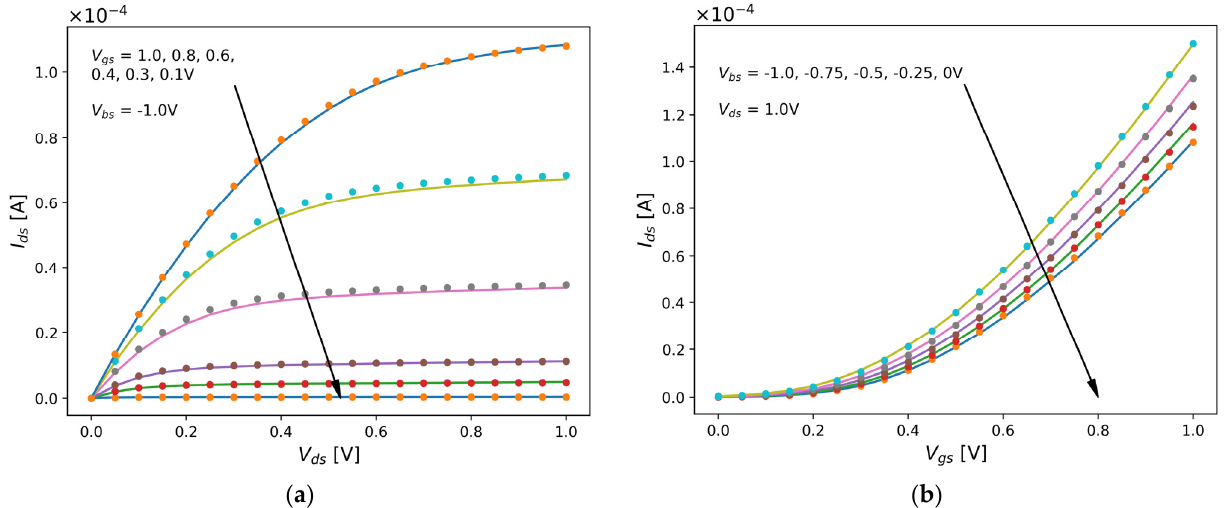
Figure 14. IV fitting curves of the second set of measured data: ( a ) I ds –V ds curves with T = 25 °C , W = 800 nm, L = 500 nm; ( b ) I ds –V gs curves with T = 25 °C , W = 800 nm, L = 500 nm.